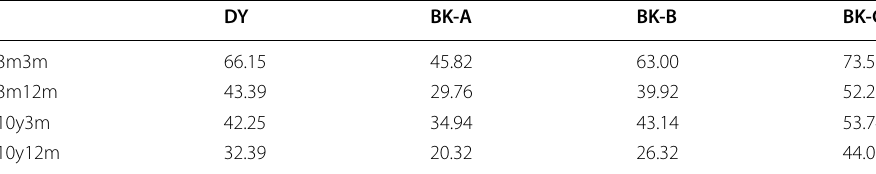
Table 1 Total connectedness summary